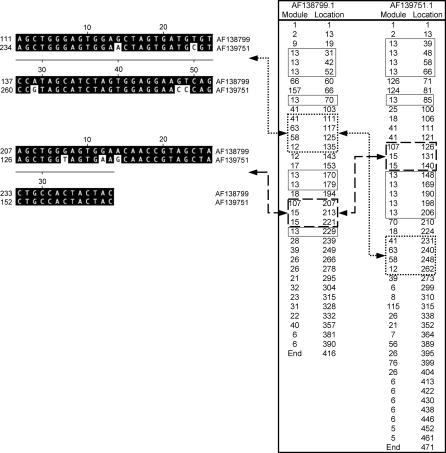
Module Maps and Module RearrangementsShown (right panel) is the module content (column Module) and nt position of the module start site (column Location) of two sof sequences (AF138799 and AF139751); this diagram constitutes a module map. Two major blocks of modules are boxed: short dashes for Modules 41, 63, 58, and 12, and long dashes for Modules 107 and 15. Arrows connecting boxes indicate their relative position within each sof allele; the corresponding aligned sequence segment is also shown (left panel). Multiple instances of occurrence of the highly repetitive Module 13 are boxed (thin lines) in order to highlight its position relative to the two major blocks of modules. The module slip threshold parameter (set to 4 nt), which is used in the iterative module correlation process, leads to the identification of sequence segments that are offset by ±4 nt sites; when the offset exceeds twice the module slip threshold parameter, an additional occurrence of that module is declared, even though the start sites of the two modules may be positioned only 8 nt apart. Module start site slippage and discrete blocks composing multiple copies of the same module are depicted in the module maps.